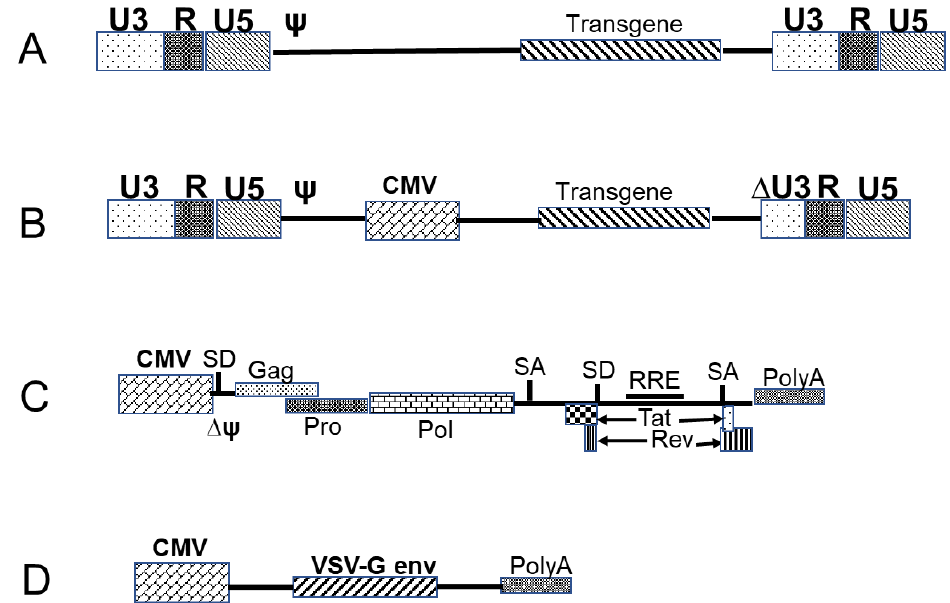
Figure 1. Retrovirus-based vectors. ( A ) Representation of a retrovirus-based vector, and ( B ) a SIN lentiviral-based vector. The long terminal repeat (LTR) is divided into three regions (U3, R and U5). The packaging of the viral RNA takes place via interaction between the packaging signal ψ and the viral proteins. The bonding of Rev to the rev response element (RRE) enables the transport of un-spliced or once-spliced RNA from the nucleus to the cytoplasm. ( C ) A helper plasmid with viral protein gag-pro-pol under the expression of the cauliflower mosaic virus (CMV) promoter. ( D ) A helper plasmid for the env protein.